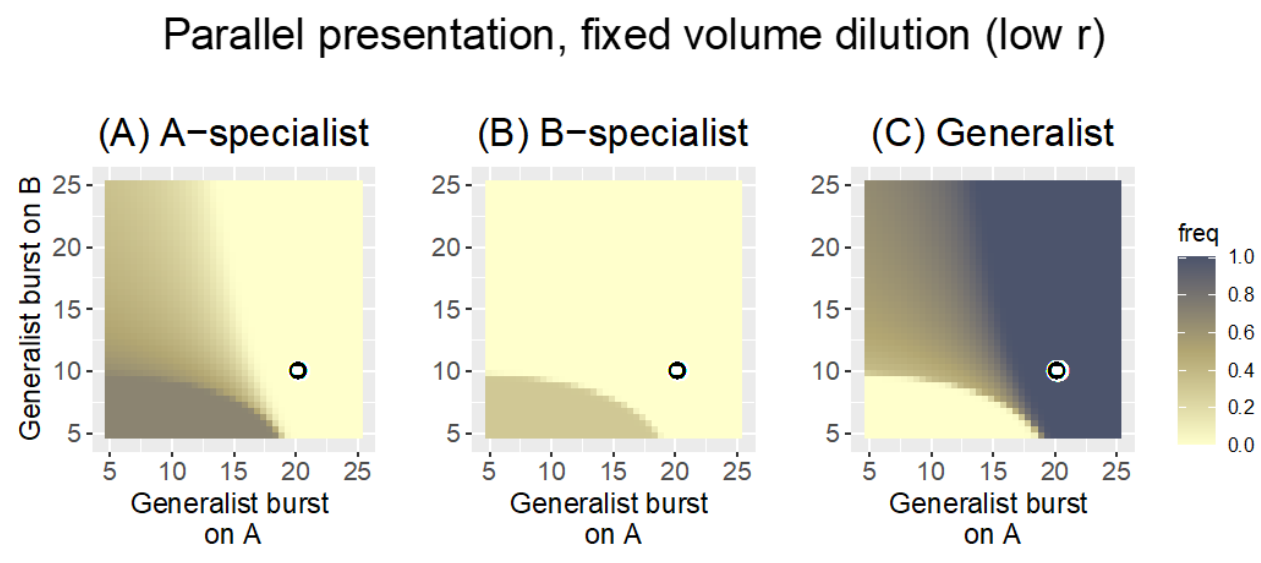
Figure 6. Parallel presentation with fixed volume dilution and low bacterial growth rate ( r = 0.1). The three panels show the frequency of the A-specialist ( A ), the B-specialist ( B ), and the generalist ( C ). Trials are the same as detailed in Figure 4 except that more phage are transferred every cycle: here, 5% of the phage pool at the end of a cycle is added to each new culture instead of 1000 phage. Figure 5 showed that total phage density reached just over 10 6 per cycle with fixed-count dilution; with a final density of 10 6, the fixed volume dilution here would transfer 50,000 phage instead of 1000. The final density here at time 1000 ultimately exceeds 10 6 by orders of magnitude, however. The pattern is now much closer to that of Figure 3 ( r = 0.3, fixed-count dilution) than that of Figure 4: two phages are maintained over much of the space. Yet, there are also differences from the patterns in these other two cases — the generalist is maintained over a wider set of burst size values than in Figure 3. Burst sizes of the two specialists are again given by the coordinates of the black-on-white ring. The key is the same as in Figures 2 and 3.